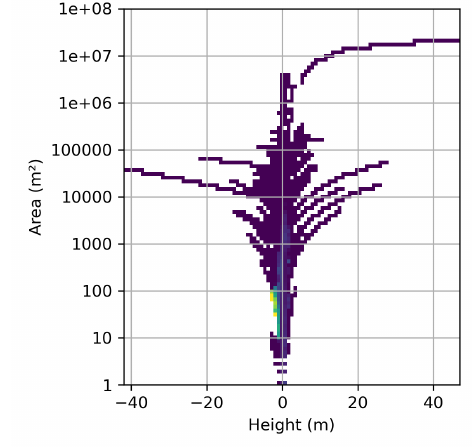
Figure 6. Activation maps of pattern spectra over the gold panning areas with the tree of shapes. The bin color represents the percentage of nodes defined as gold panning in the global spectrum. Values range from 0% (purple) to 100% (yellow).